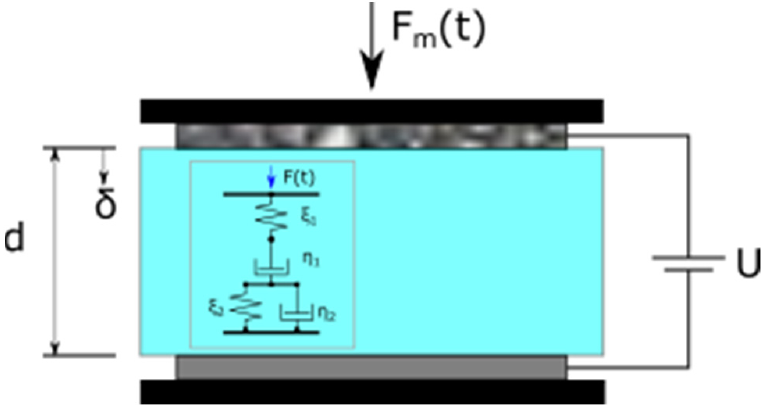
Figure 4. The actuator is considered to be modelled where the PVC gel is considered to be viscoelastic. The mechanical force (F m ) delivered using the DMA and the electrostatic force (F e ) imposed by the electrical potential (U) may be expressed as in Equation (1) [19].